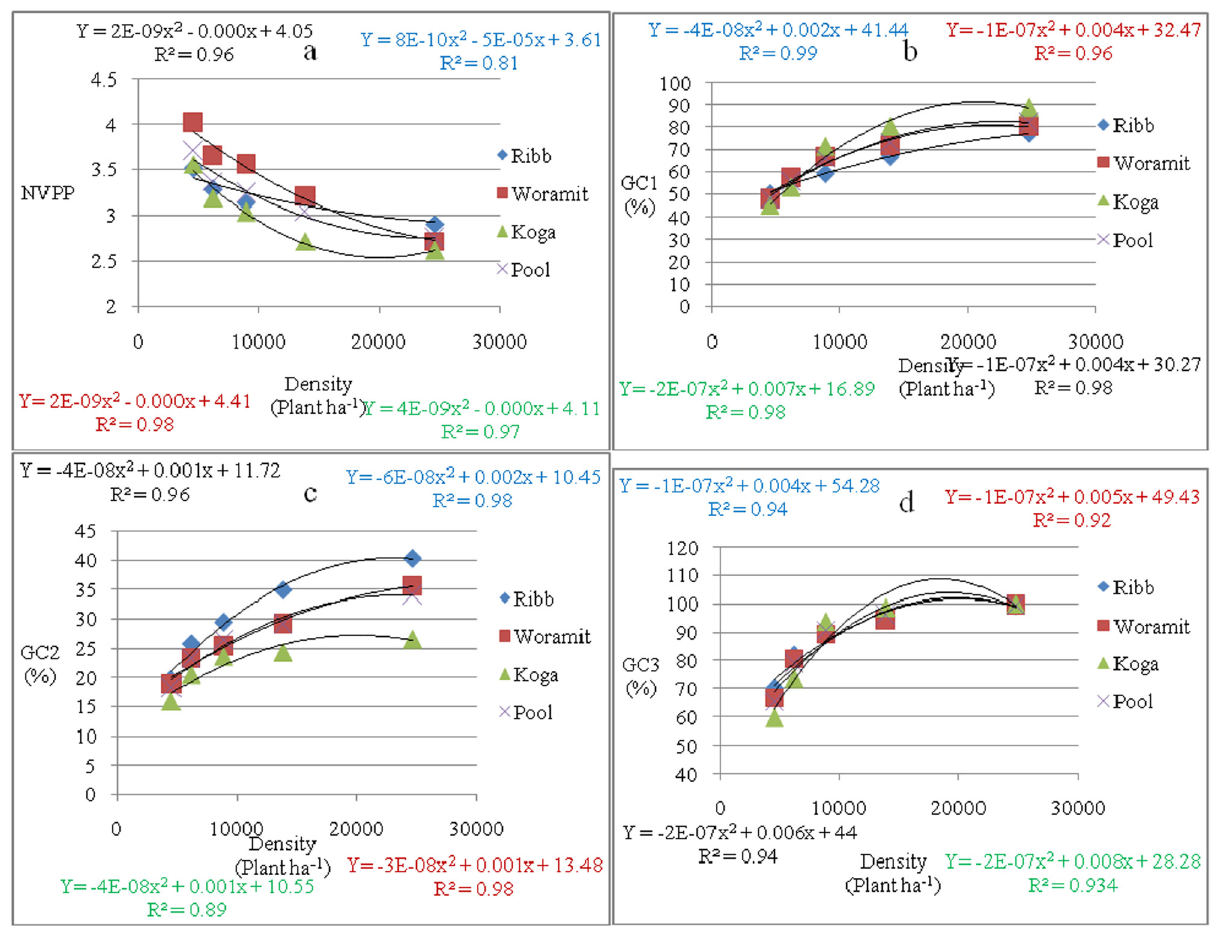
Figure 3: Vine number ( a ) and ground cover attained at ( b ) 30, ( c ) 60, and ( d ) 90 days after planting as a ff ected by plant density at each